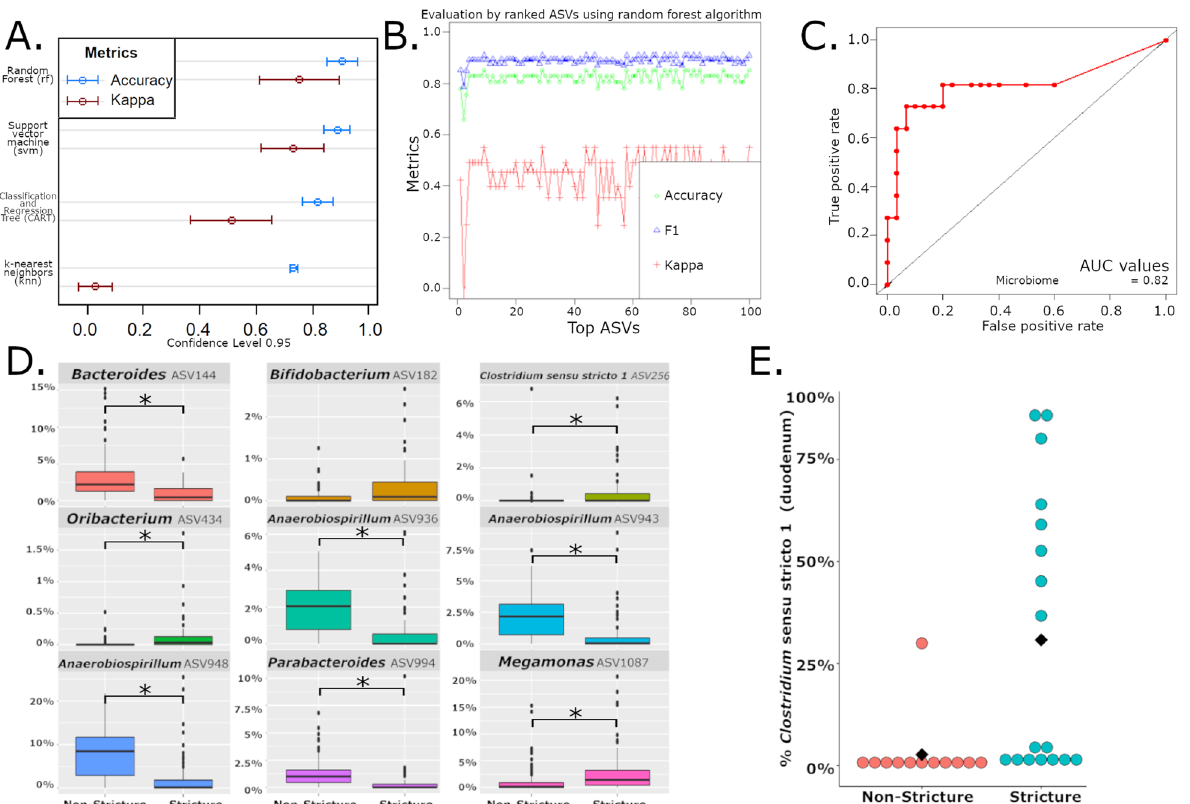
Figure 3. ( A ) Evaluation of 4 machine learning algorithms for classification of marmoset microbiomes based on stricture status. ( B ) Relationship between random forest model’s accuracy, F1 and Kappa on the number of ASVs used by the model to classify stricture and non-stricture samples with an 85% accuracy. ( C ) Area under the curve (AUC) of receiver operating characteristic (ROC) curves for random forest models using microbiome shows strong performance of models in classifying strictures and non-strictures. ( D ) Comparison of the relative abundance of the 9 ASVs identified in the random forest model in stricture and non-stricture samples. ANCOM analysis at the ASV level determined 8 of 9 ASVs to be significantly different between stricture and non-stricture. *= (W > 571) E) Evaluation of relative abundance of Clostridium sensu stricto 1 reads in duodenal biopsies demonstrates increased abundance in stricture cases compared to non-stricture